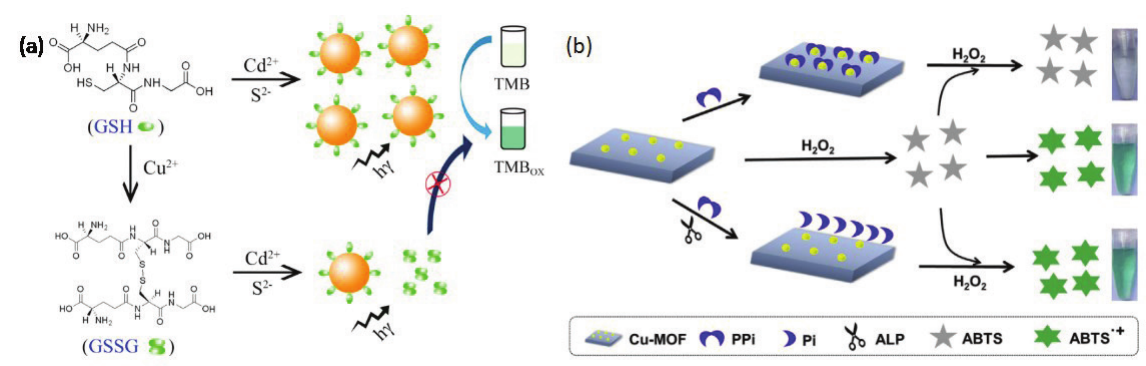
Figure 2: (a) Schematic diagram of alkaline phosphatase activity detection. Reprinted image with permission from Ref. [61], Copyright 2016, Elsevier B.V. (b) Pyrophosphate (PPi) colorimetric sensor based on BSA-AuNCs-Cu 2+ . Reprinted image with permission from Ref.